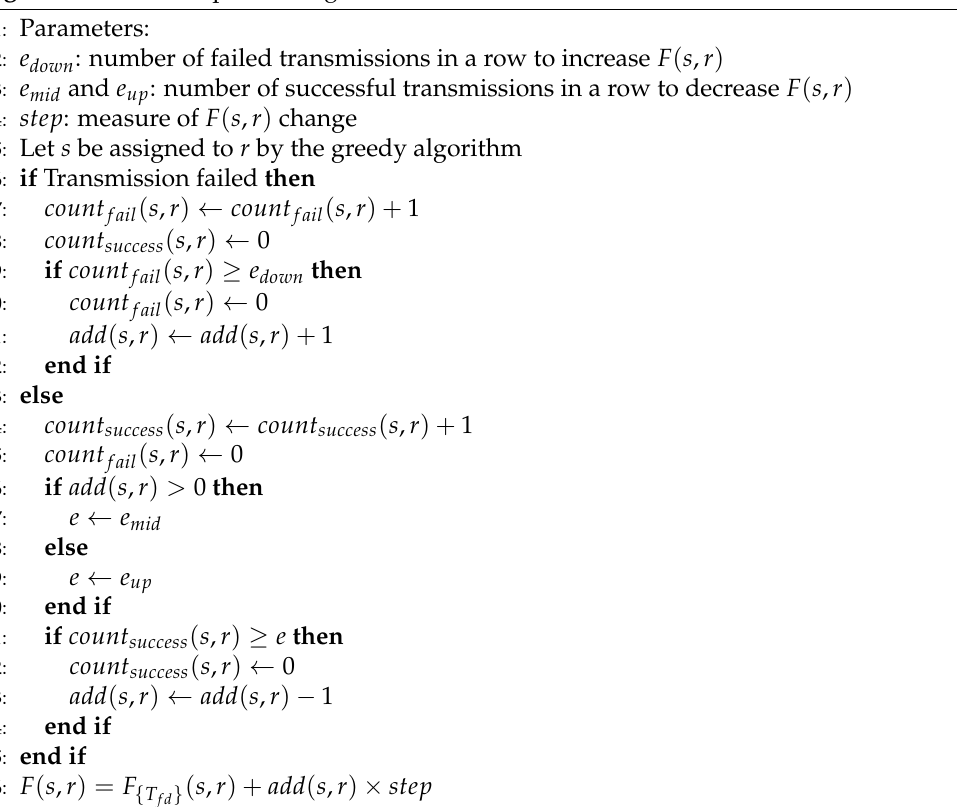
Algorithm 2 CSI Adaptation